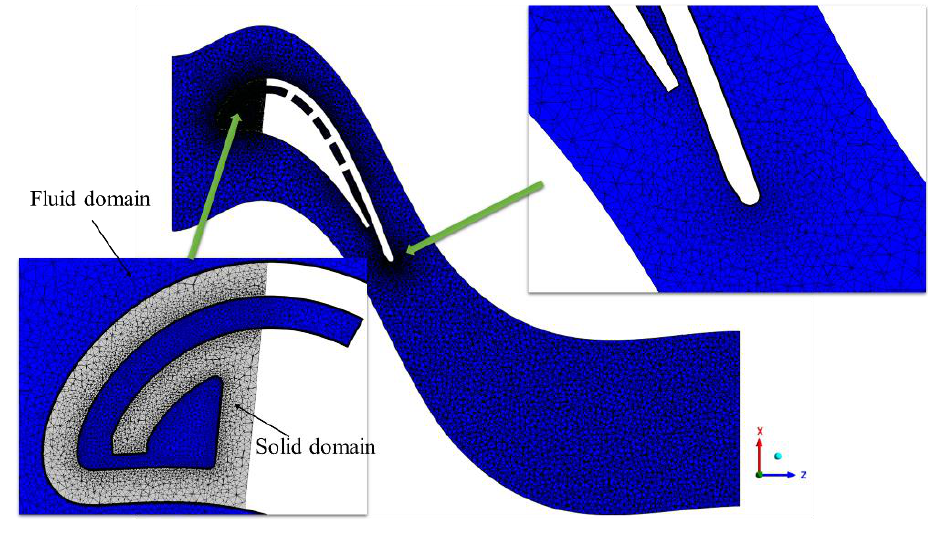
Figure 5. Grid details of the internal cooling structure.